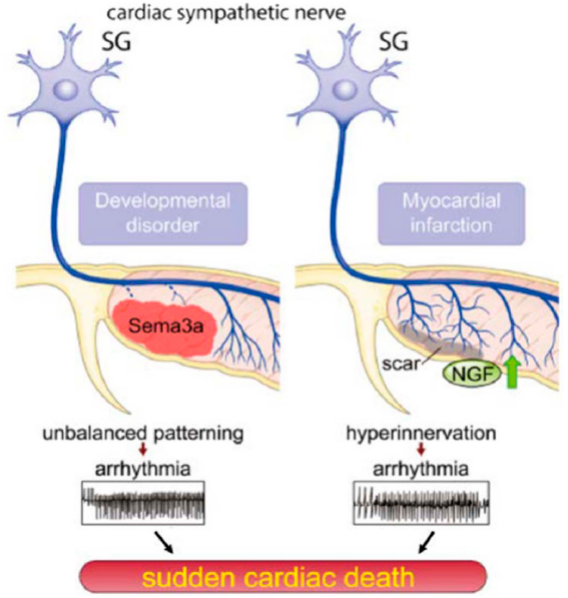
Figure 10. Cardiac innervation patterns provoking sudden cardiac death. Left: Overexpression or underexpression of Sema3a, a class 3-secreted semaphorin, which acts as a potent neural chemorepellant, leads to abnormalities in innervation patterning of sympathetic nerves causing ventricular arrhythmias and sudden cardiac death. Right: Overexpression of NGF leads to a disrupted patterning of sympathetic neurons leading to hyperinnervation, ventricular arrhythmias, and sudden death [121]. Upregulation of secreted nerve growth factor (NGF) from cardiomyocytes in diseased heart (NGF and green arrow) may cause lethal arrhythmia (red arrows) and SCD (black arrows).